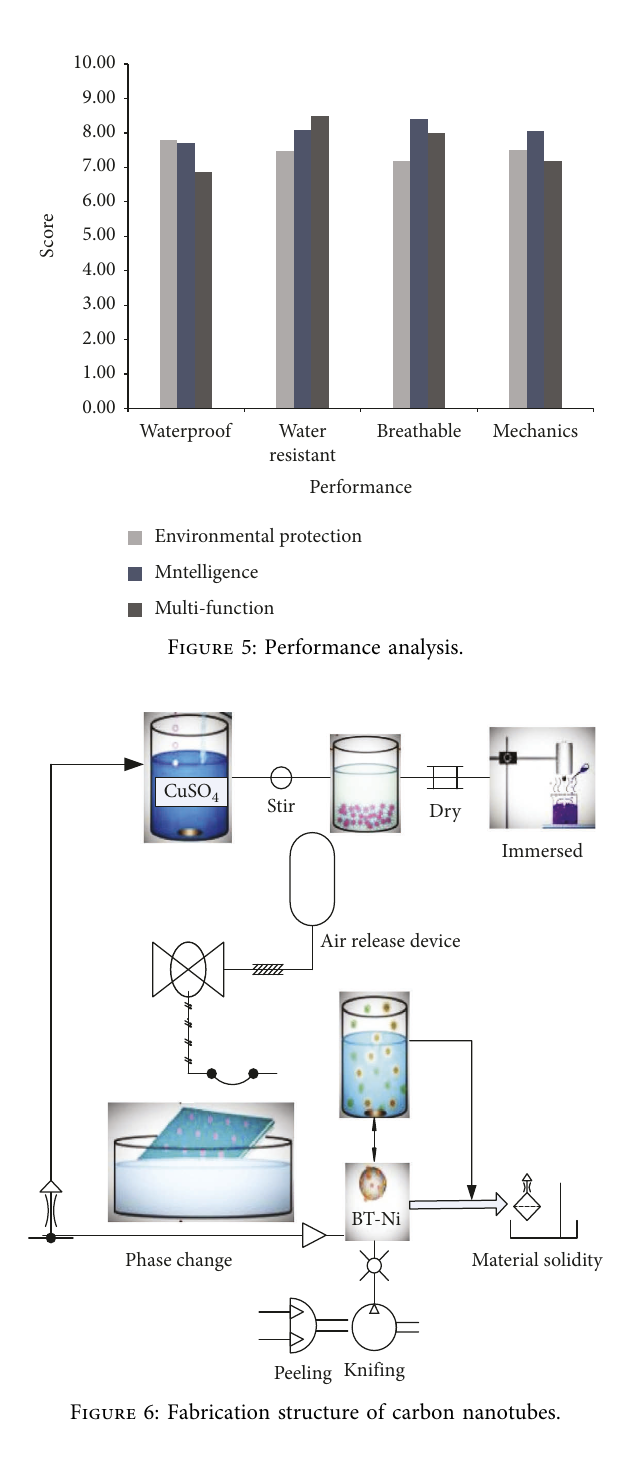
Figure 6: Fabrication structure of carbon nanotubes.